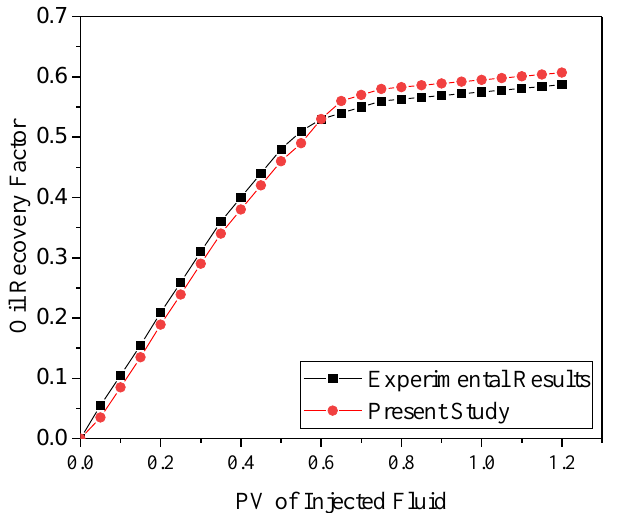
Figure 6. Evaluation of curve changes in the amount of oil recovered from porous medium computed from the model and experimental data [93].